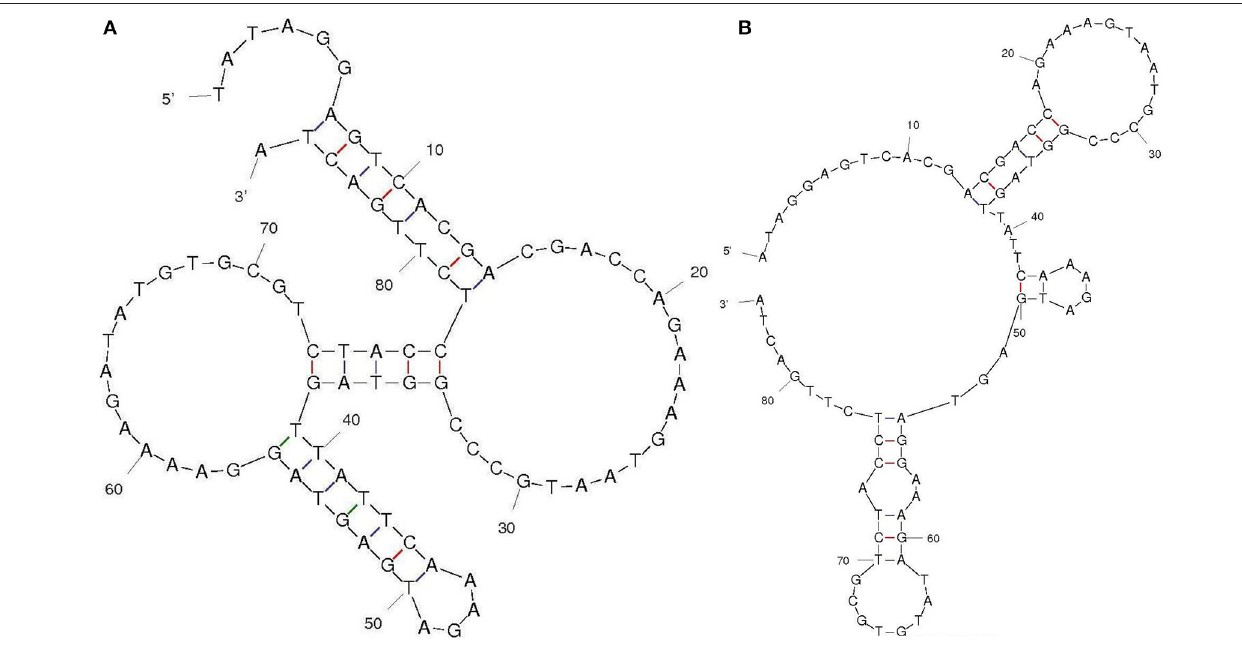
FIGURE 2 | Aptamer secondary structure. Selected aptamer secondary structures and dissociation constant predicted through M-fold software (A) AFB1a and (B) AFB1b.